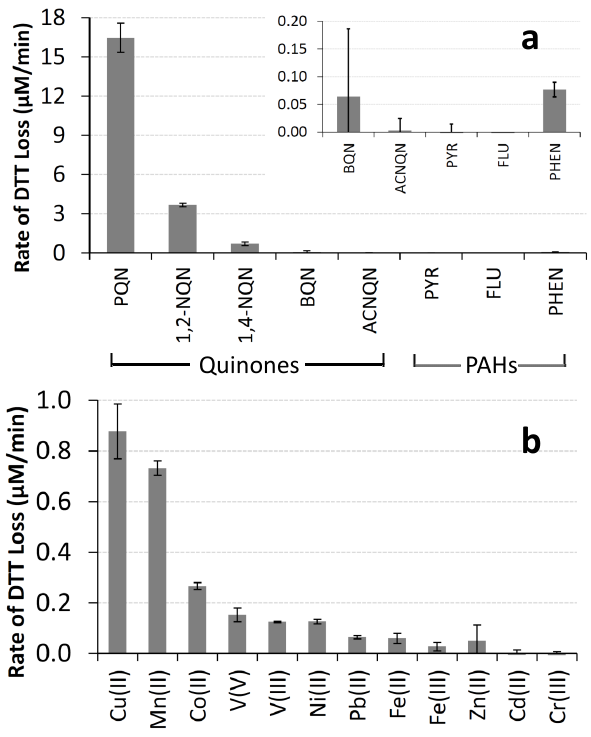
Fig. 3. Blank-corrected rates of DTT loss from five quinones and three PAHs (a) and from 12 transition metals (b) . The concentration of each species was 1µM, except for BQN which was 0.93µM, 1,4- NQN which was 1.21µM and Cd(II), which was